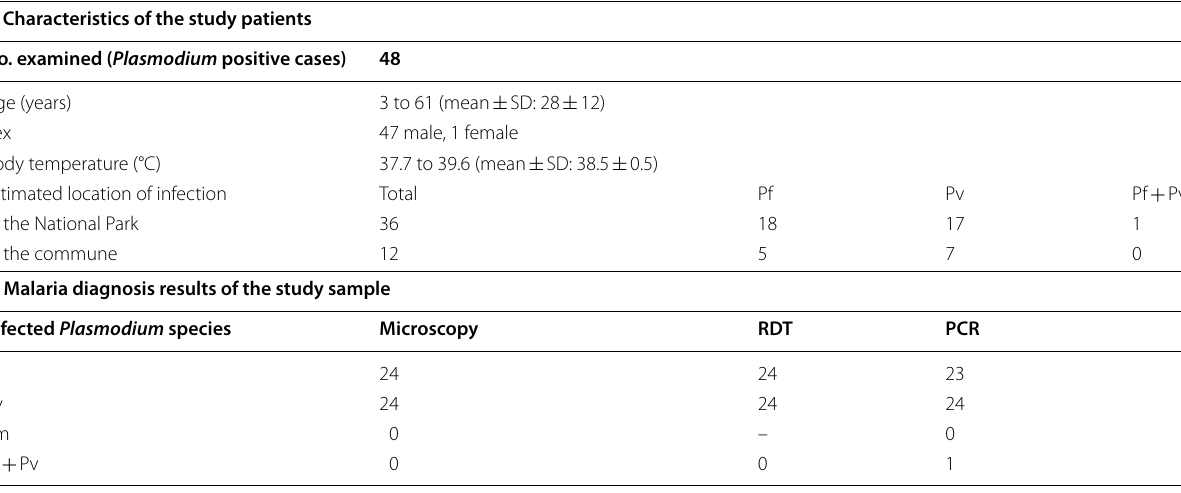
Pf: P. falciparum ; Pv: P. vivax ; Pm: P. malariae ; Pf